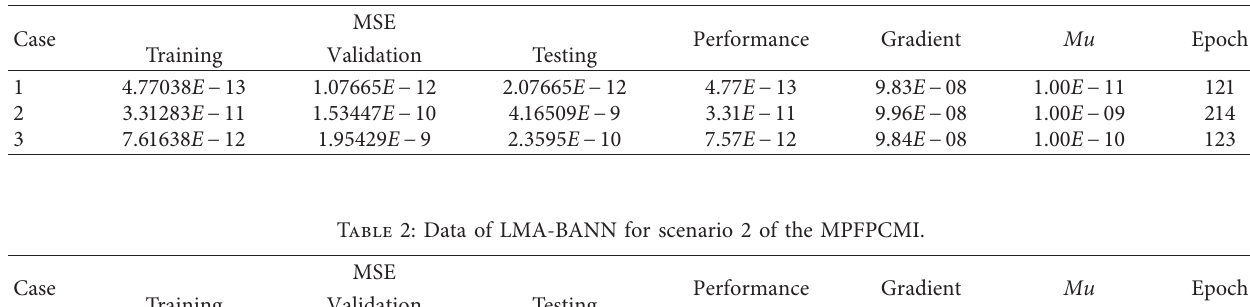
Figure 5: Regression plot of LMA-BANN for two cases of the MPFPCMI Table 1: Data of LMA-BANN for scenario 1 of the MPFPCMI.